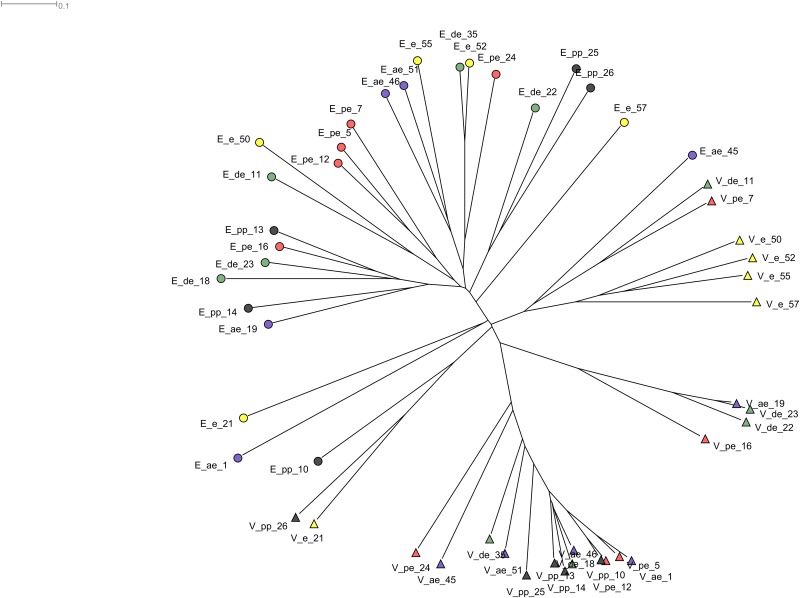
Neighbor-joining tree drawn at genus level.Circles represent endometrial samples while triangles are vaginal samples. Stages of estrous are color-coded. Anestrus (ae)-yellow, estrus (e)-green, diestrus (de)-green, pro-estrus (pe)-red, and pre-pubertal (pp)-gray.